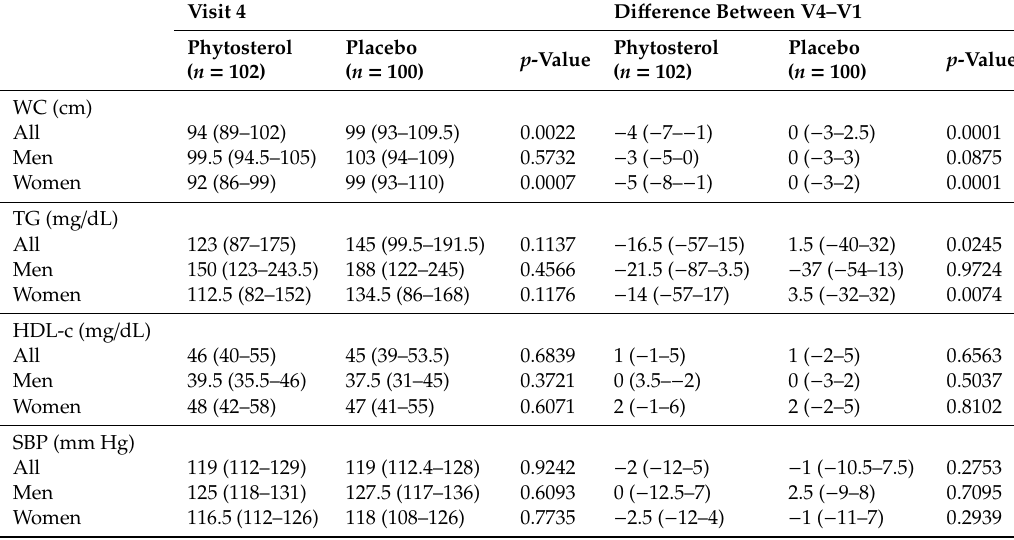
group. All data are presented as median and 25th–75th